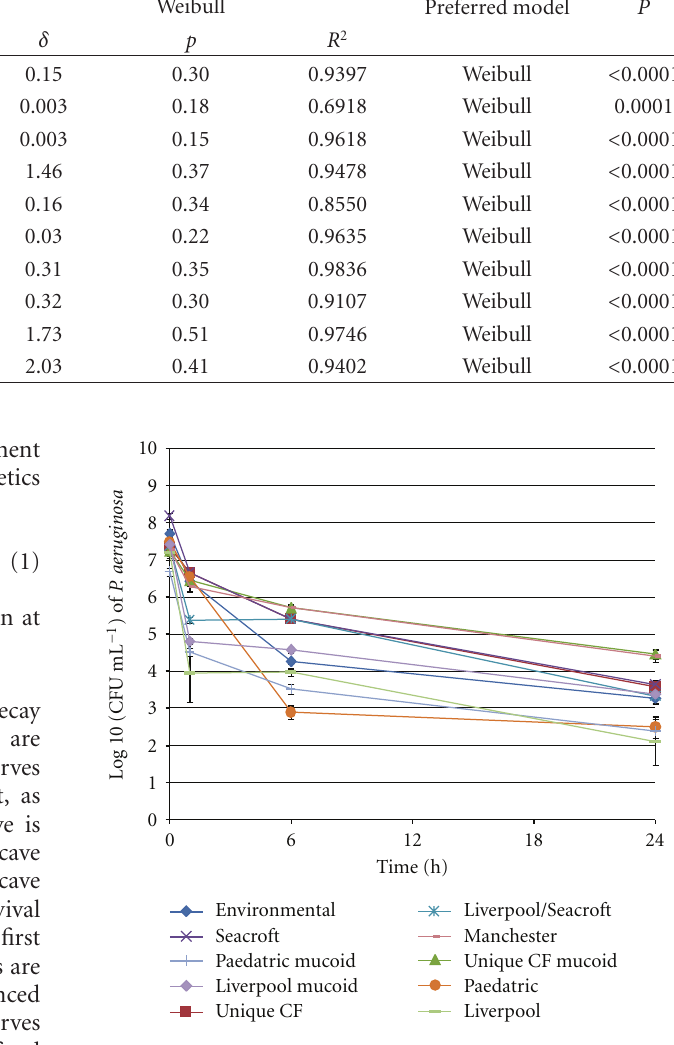
Figure 1: Mean viable counts of di ff erent strains of P. aeruginosa within the desiccation survival model. Error bars represent standard error of